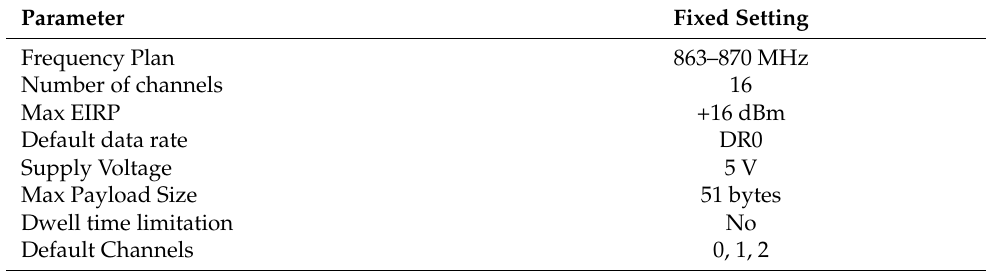
Table 3. Default Board Settings For Testing.